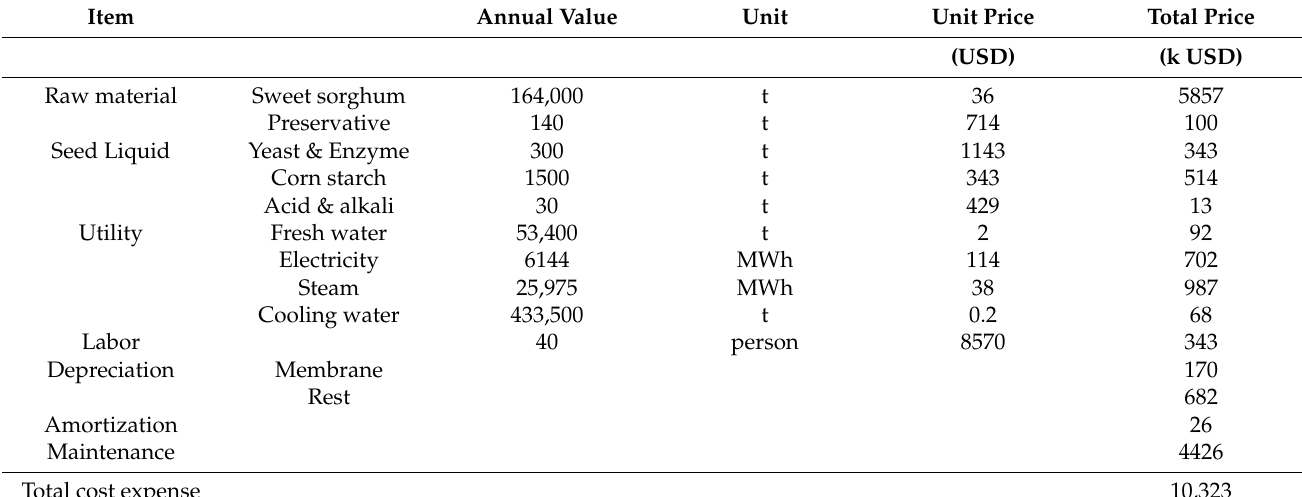
Table 6. Total cost expenses of OPTS 10,000 tons fuel ethanol per year